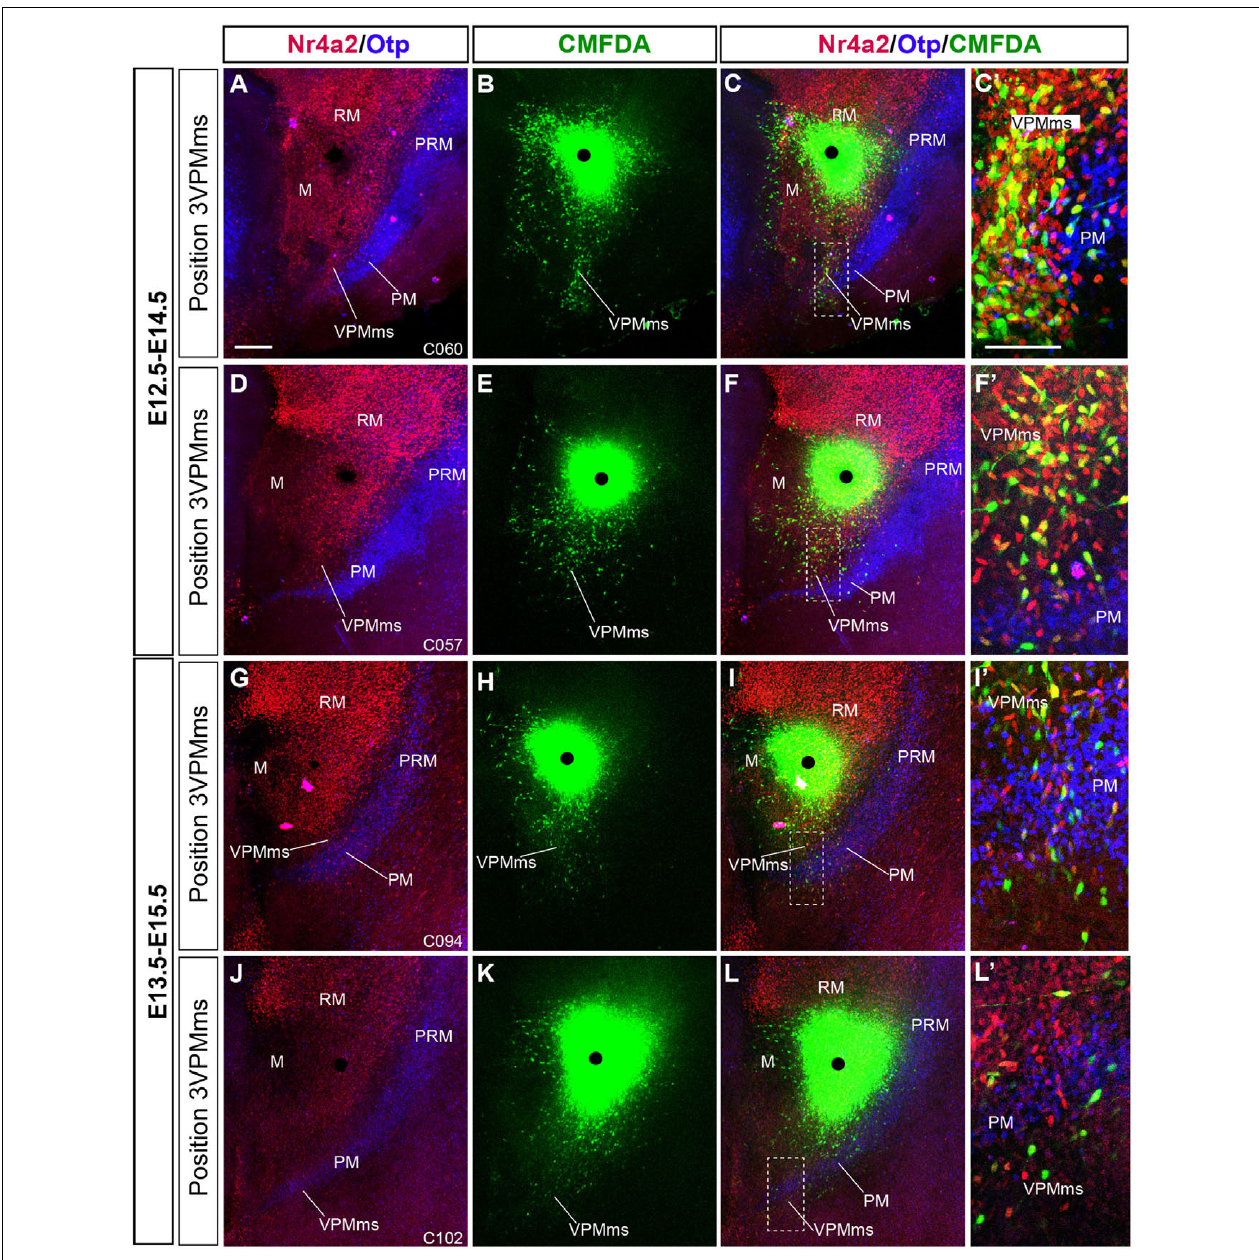
FIGURE 9 | Comparison of VPMms labeling experiments performed at E12.5 and E13.5. We illustrate similarly as in Figure 11 , with Nr4a2 and Otp background labeling of RM/VPMms and PRM/PM, respectively, two representative cases of our E12.5–14.5 series (A–F) , compared with two cases of our E13.5–E15.5 series (G–L) . The number of labeled VPMms cells seems to decrease in the latter group. (C’,F’,I’,L’) Higher magnification images taken from the boxed-in areas in (C,F,I,L) , showing fluorescence-typological VPMms cell details, as observed in Figure 11 . Note that E12.5-E14.5 cases have more CMFDA + Nr4a2 (yellow) cells than E13.5–E15.5 cases. Scale bar in (A) represents 200 µ m valid for (B–L) . Scale bar in (C’) represents 100 µ m and is valid for (F’–L’) .